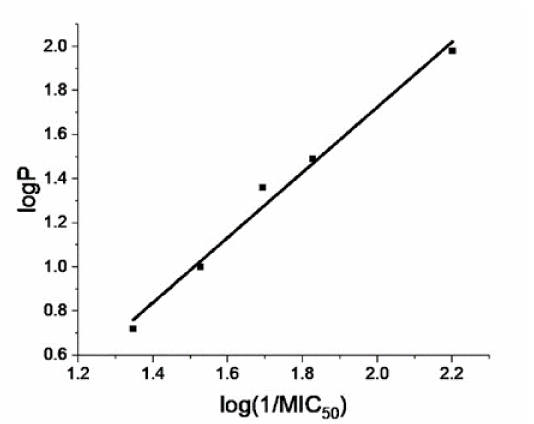
Figure 5. The logP values of 2-PEtOH linearly correlate with the log(1/MIC 50 ) values. The logP values of 2-PEtOH and derivatives is plotted against the respective log(1/MIC 50 ) values. The correlation coefficient is r 2 =